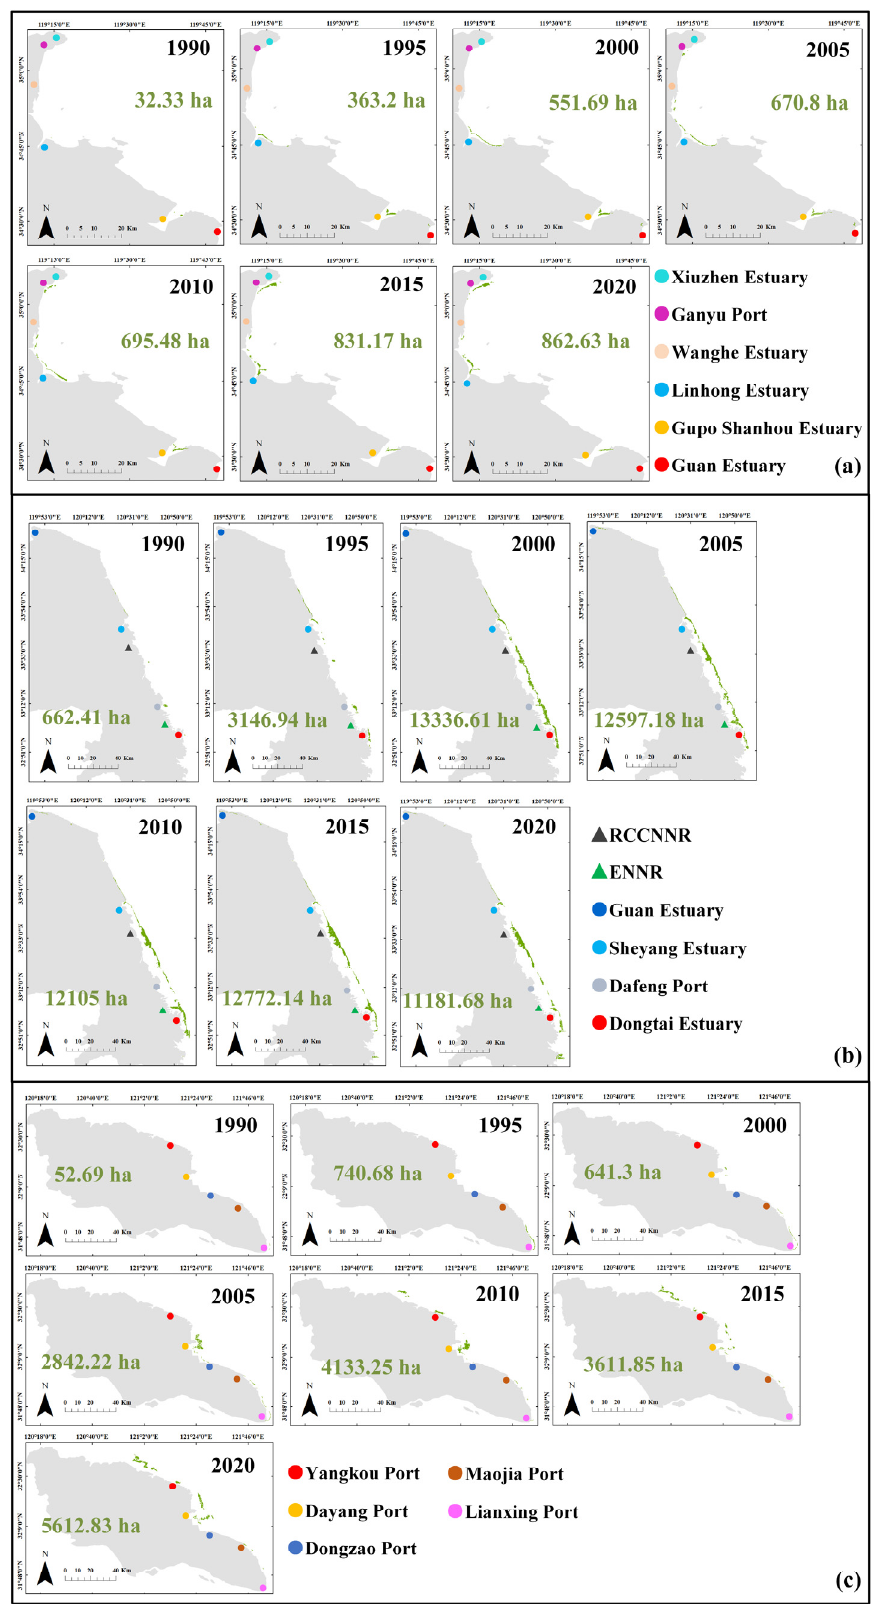
Figure 9. Distribution area (ha) of S. alterniflora in coastal wetlands of Jiangsu province from 1990 to 2020. Green is S. alterniflora . ( a ) Lianyungan; ( b ) Yancheng; ( c )